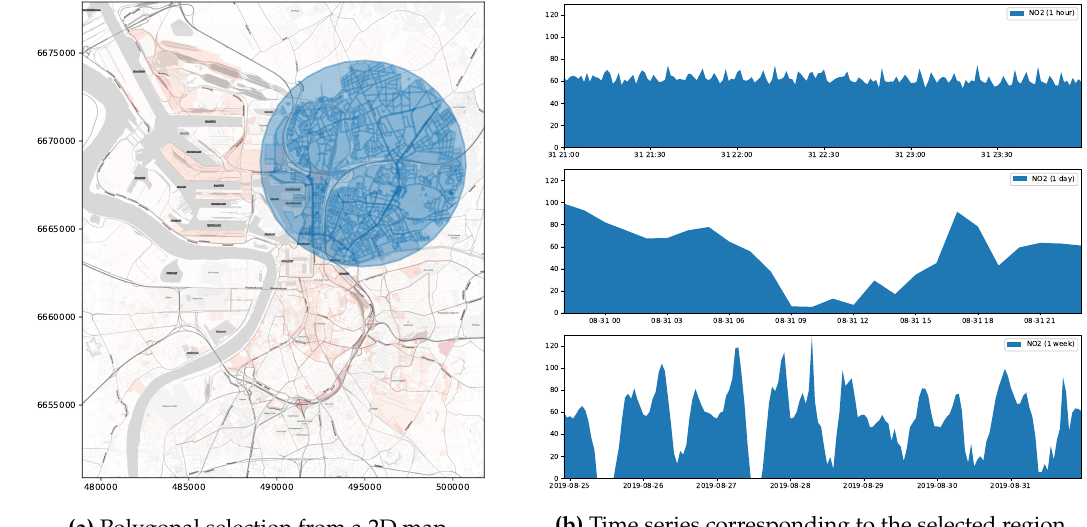
Figure 2. Example of a general exploratory task: ( a ) the visual query prompted by the user: How have the NO 2 emissions historically evolved within the traced perimeter? ( b ) Three time series charts reporting on the concentration of the NO 2 over the past one hour, 24 h, and one week.